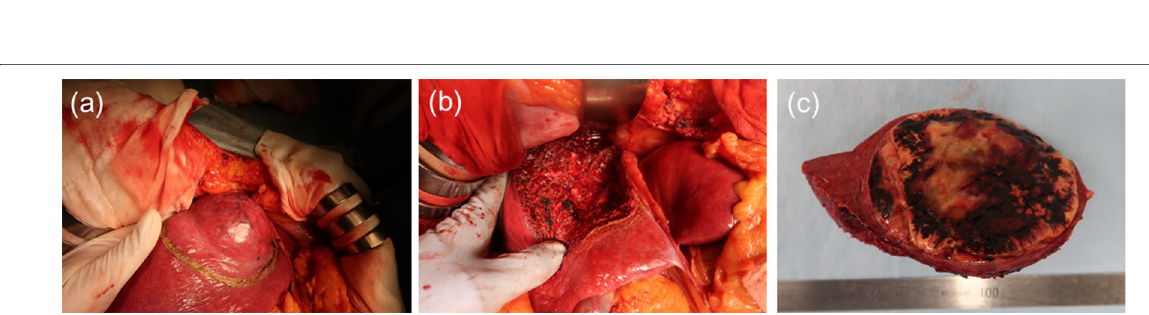
Fig. 4 Intraoperative photographs and macroscopic view of the resected specimen. a Tumor was located in segment 8 of the liver. The tumor protruded from the liver surface. b Resected surface of the liver after extended anatomical resection of the liver segment 8 ventral area. c Macroscopic view of the resected specimen. A yellowish, solid 7 cm tumor was seen, with hemorrhage and